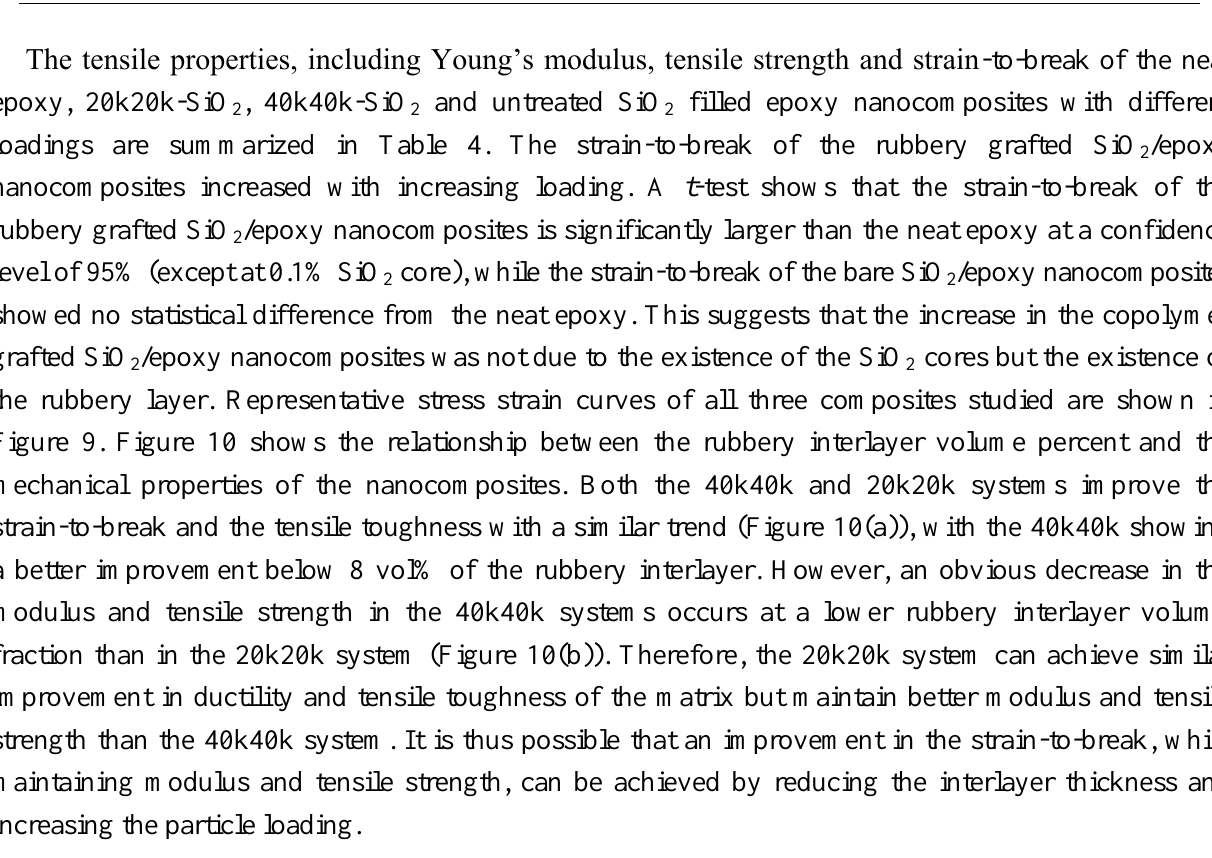
Table 4. The tensile properties of the nanocomposites and the neat epoxy. Error estimates are the measured standard